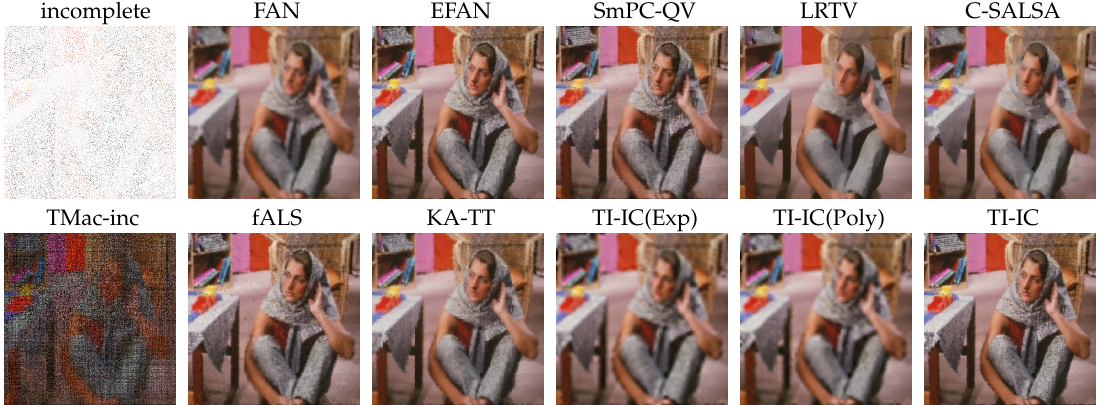
Figure 2. Test A (90% randomly missing pixels) for the image